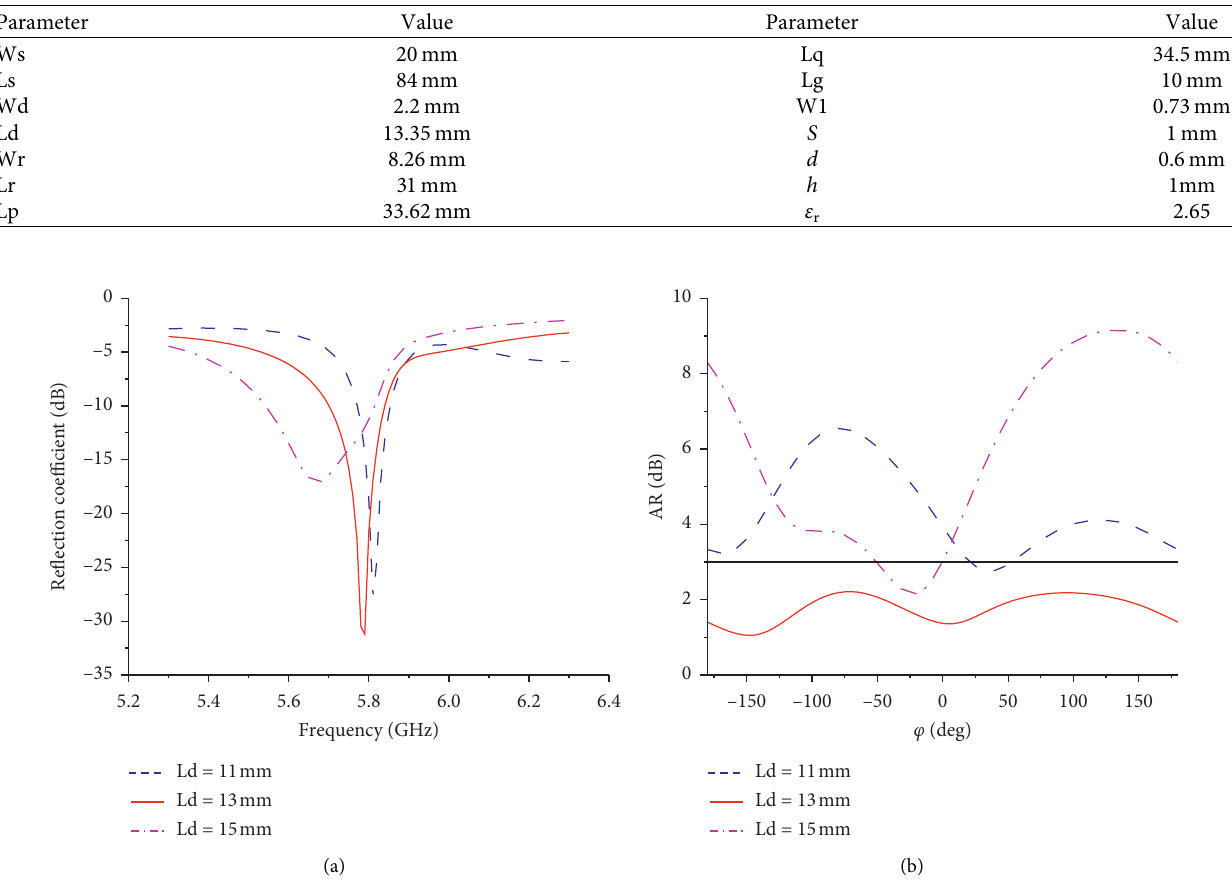
Figure 3: The influence of parameter Ld on antenna performance.